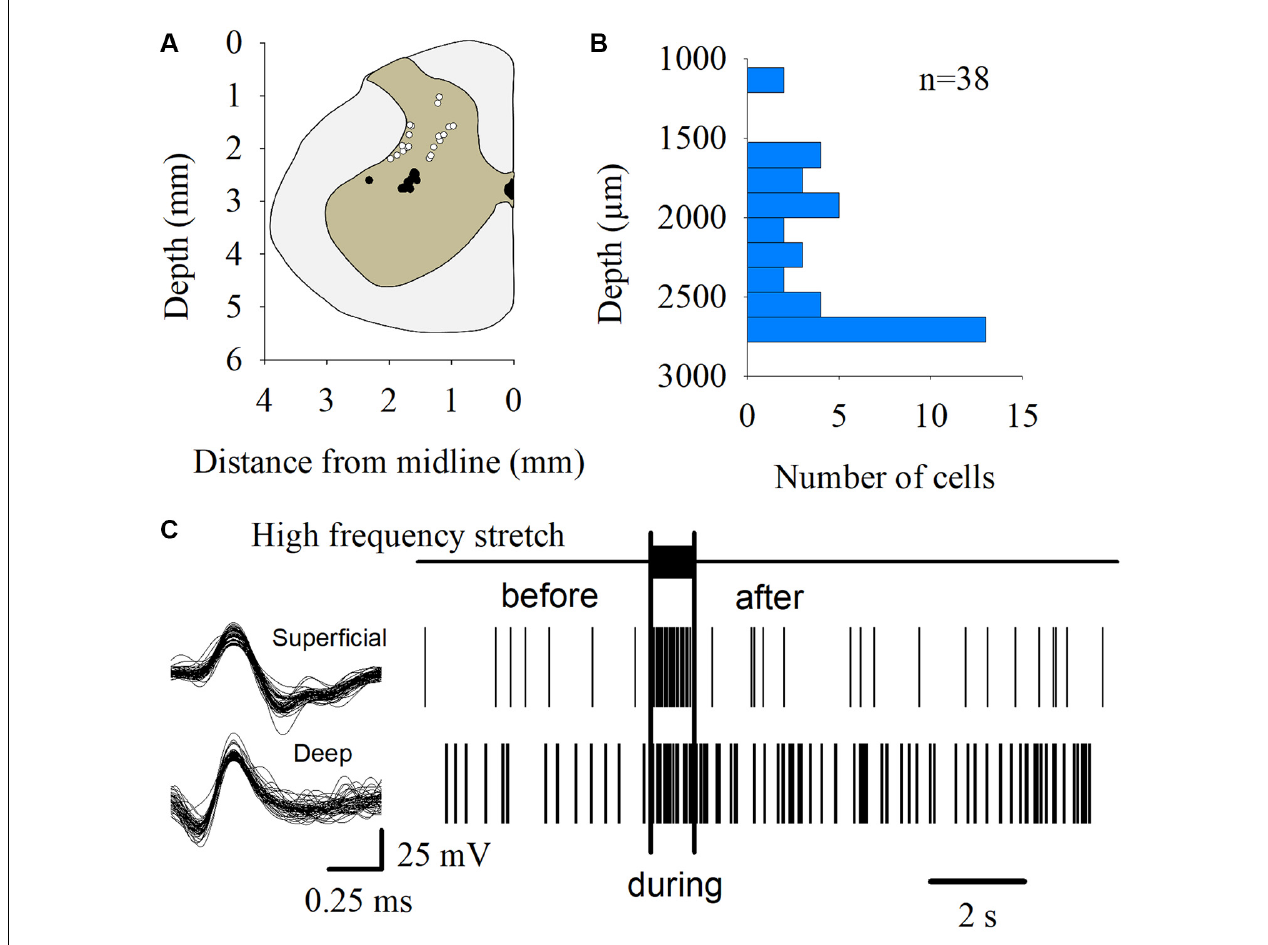
FIGURE 3 | Multiunit recording of lumbar interneurons from the superficial and deep dorsal horn. (A) The white and black circles represent the sites from which the multiunit recordings of the spinal neurons were performed. The white circles represent the superficial dorsal horn neurons. The black circles represent the deep dorsal horn neurons. (B) Distribution of the depth of the recorded interneurons ( n = 37) shown in (A) . (C) Scheme representing the spike-sorting for both the superficial and deep dorsal horn neurons, as indicated. Note that the superficial dorsal horn neurons exhibited a slower firing rate than the deep dorsal horn neurons. The signals from single interneurons were obtained from the raw multiunit activity (MUA). The waveforms illustrated in the left panel are superimposed traces of two interneurons from two different animals. The right panel shows the raster plots of such neurons in response to the high-frequency stretch of the Achilles tendon (uppermost trace and vertical